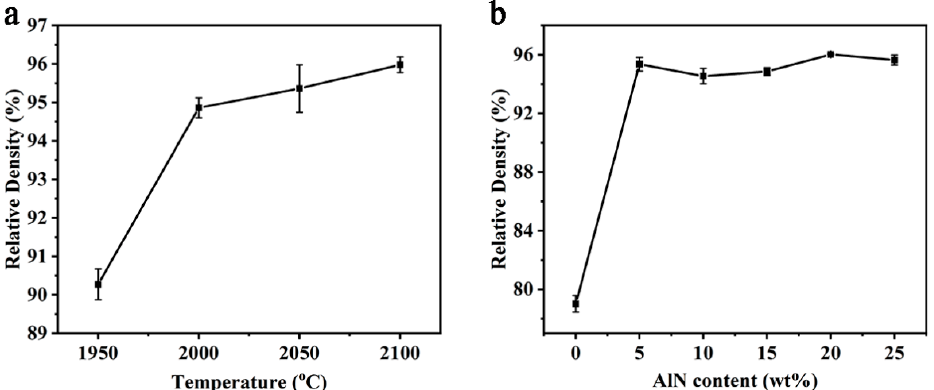
Figure 2. Relative density: ( a ) P70Z15A15 at different sintering temperatures and ( b ) samples with 15 wt% ZrB 2 sintered under 2000 °C by different AlN content.